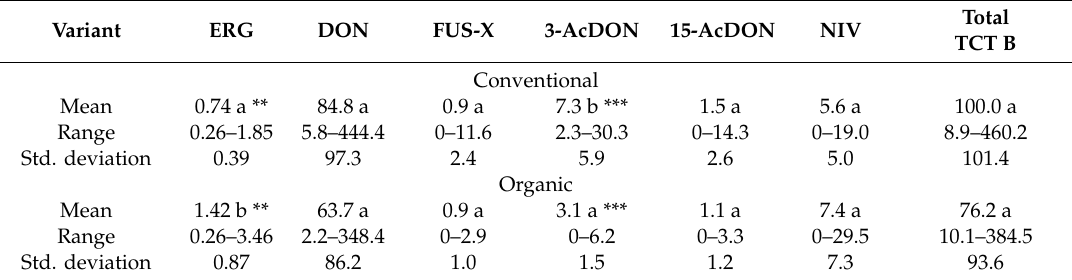
Table 5. Concentrations of ergosterol (mg kg − 1 ) and type B trichothecenes ( µ g kg − 1 ) in grain of 30 wheat cultivars grown in conventional and organic fields.